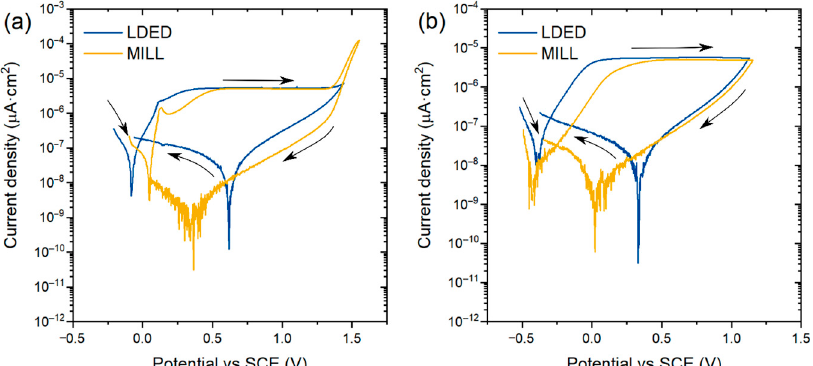
Figure 11. Representative cyclic potentiodynamic polarization curves of both MILL and LDED samples. ( a ): curves obtained into aerated artificial saliva media; ( b ) curves obtained into deaerated artificial saliva media.